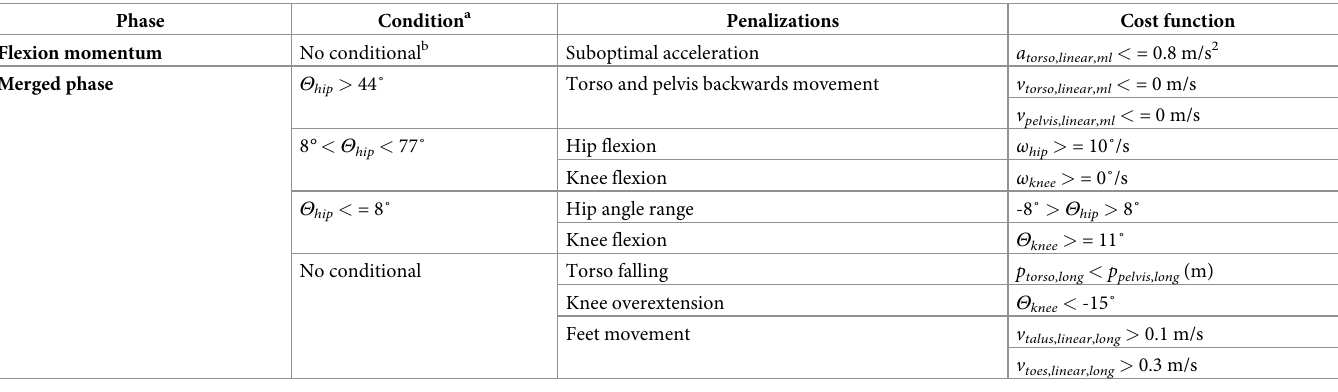
Table 4. Phase-dependent penalizations in the cost function for the 2-phases controller